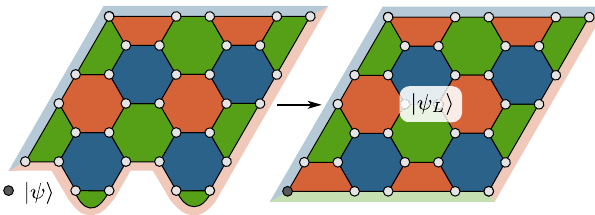
FIG. 12. Code injection procedure which encodes an unknown physical state j ψ i (gray qubit) into a logical state j ψ stabilizer state in the left panel is prepared by measuring all the stabilizers shown. Finally, we cease measuring the green stabi- lizers at the bottom boundary and start measuring the red stabilizers.